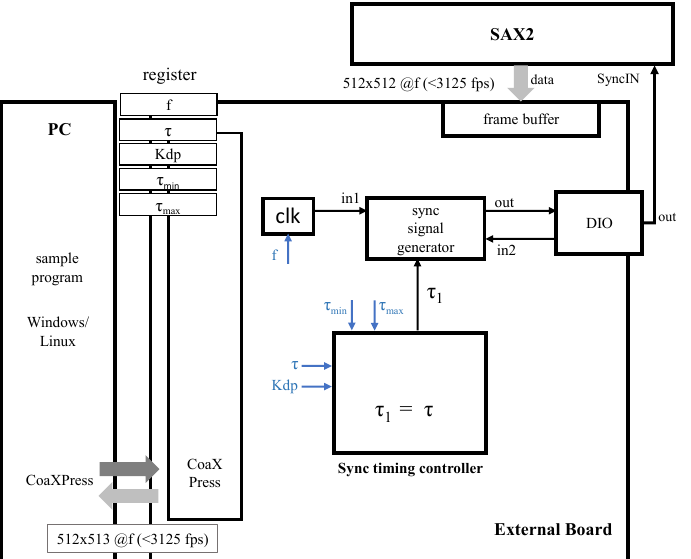
Figure 3. Control logic for visual-feedback-based projector–camera synchronization implemented on an external board.